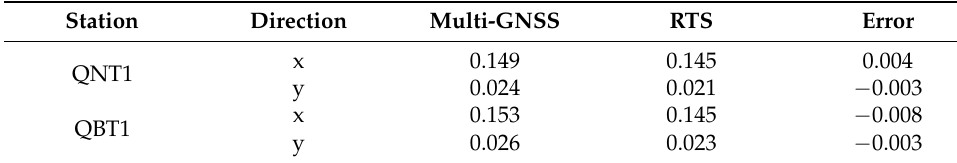
Table 10. The deformation error between multi-GNSS and RTS (m).